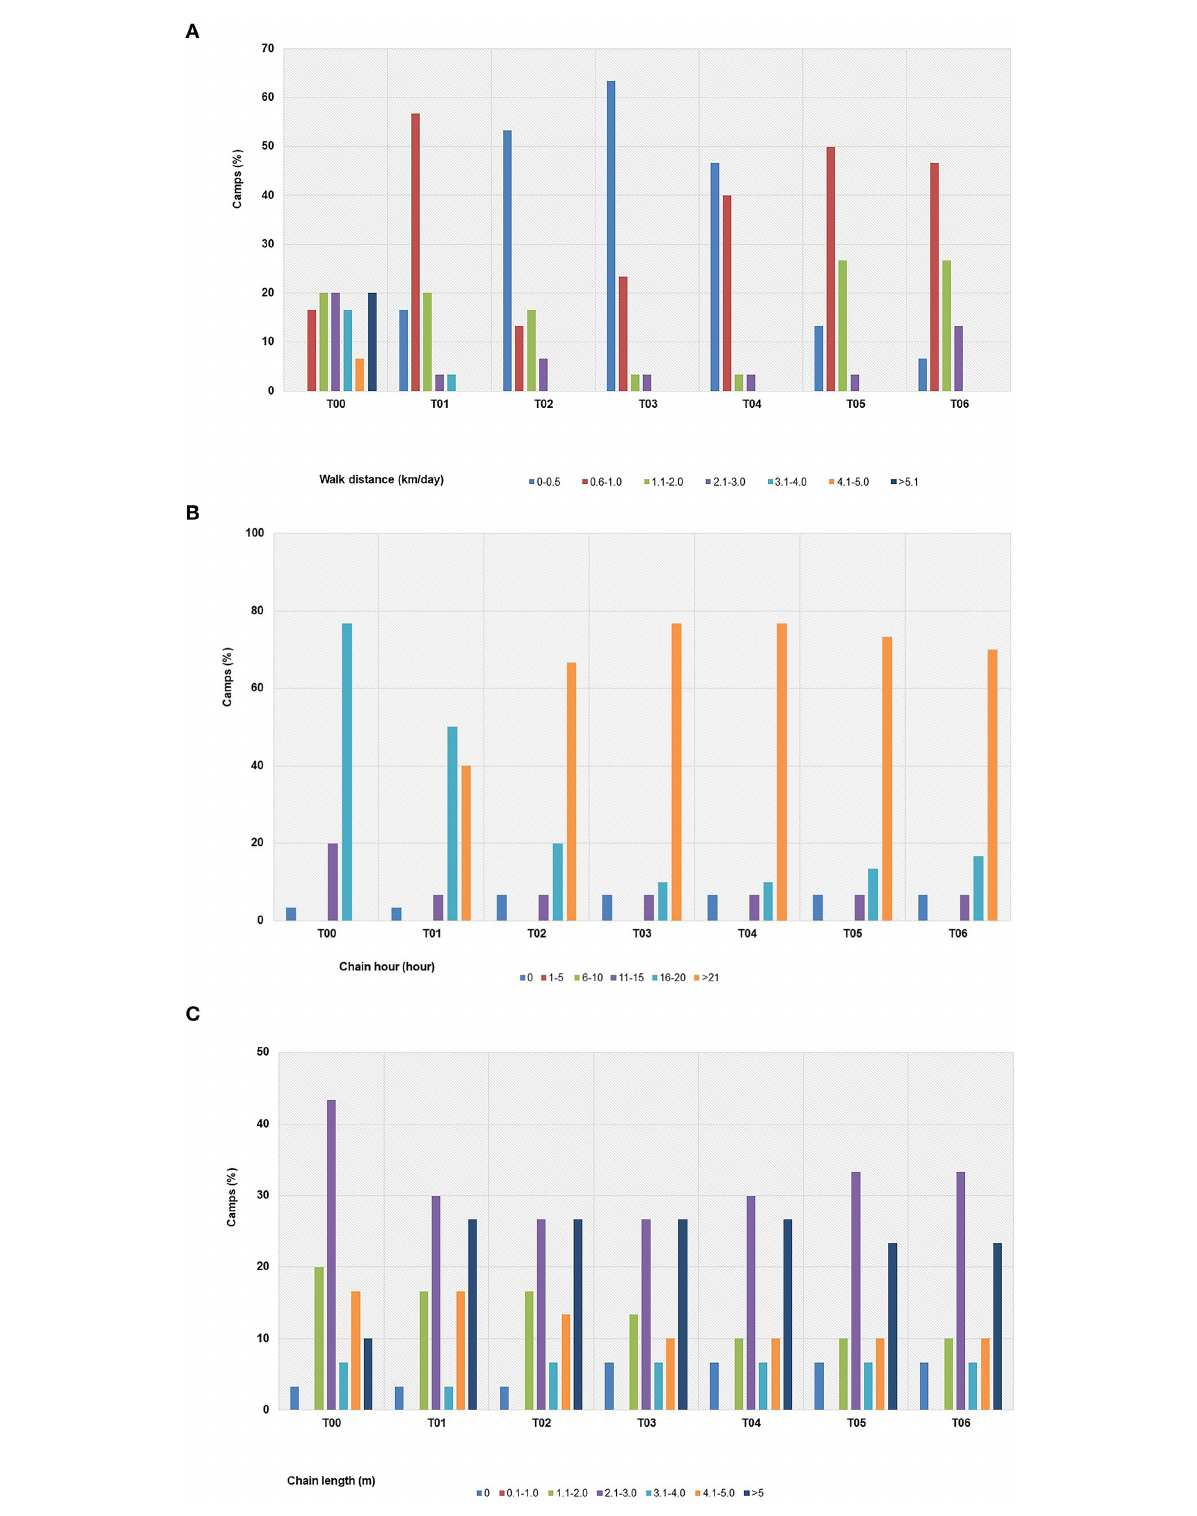
FIGURE4 Changing trends of elephant exercise (A) walking distance, (B) chain hours, and (C) chain length at individual elephant tourist camps in northern Thailand before (T00) and through six survey periods [T01 (April–August, 2020), T02 (September–December, 2020), T3 (January–April,